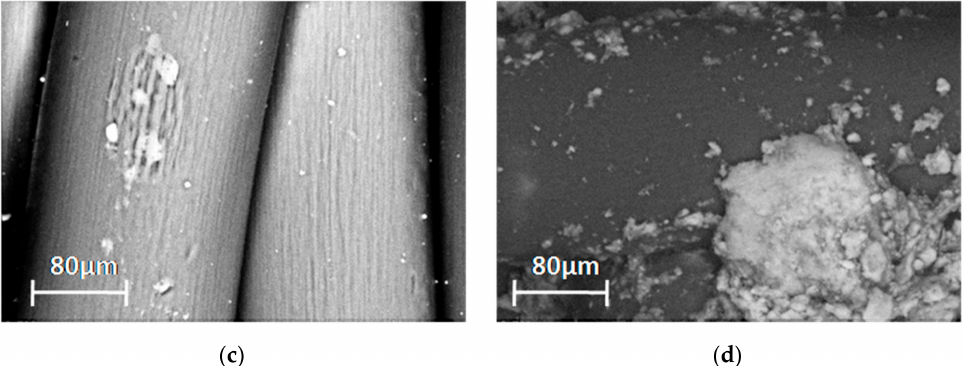
Figure 2. SEM images of ( a ) raw CO, ( c ) raw PA, ( b ) RGO/TiO 2 coated CO and ( d ) RGO/TiO 2 coated PA fibrous structures.